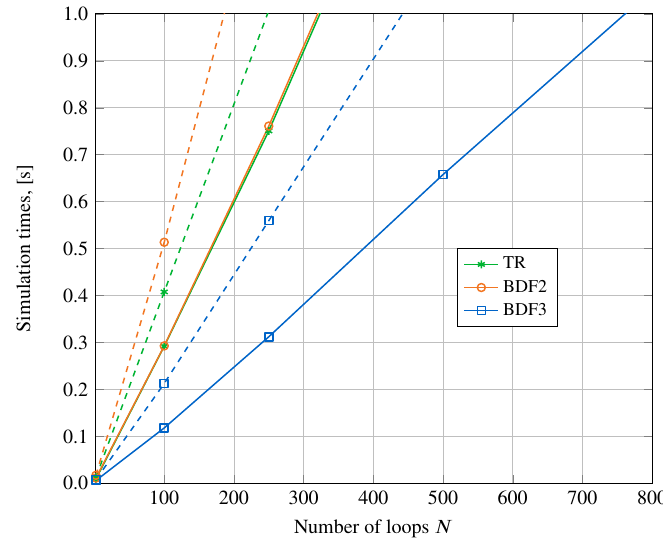
Figure 11. Scalable RLC circuit: Simulation time as a function of the number of loops ( N ) for high precision. Simulations with a constant tangent matrix are represented with solid lines; dashed lines mean refactorization of the tangent matrix in each solver